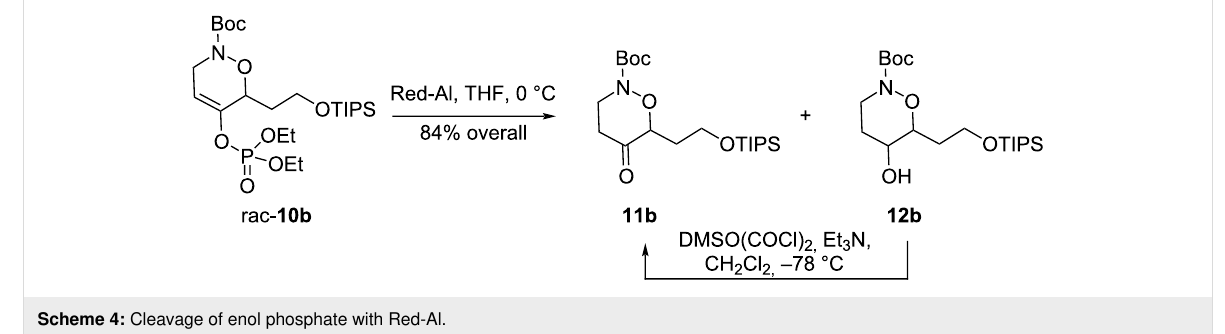
Scheme 4: Cleavage of enol phosphate with Red-Al.